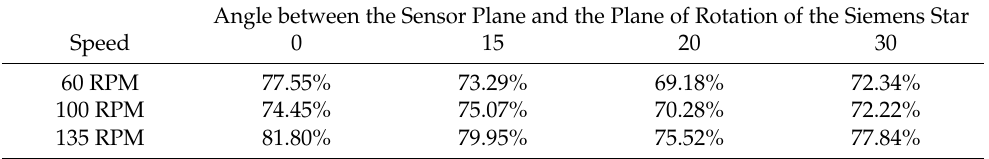
Table 3. Percentage of zero-value pixels from a static depth map that are present in a depth map with real motion